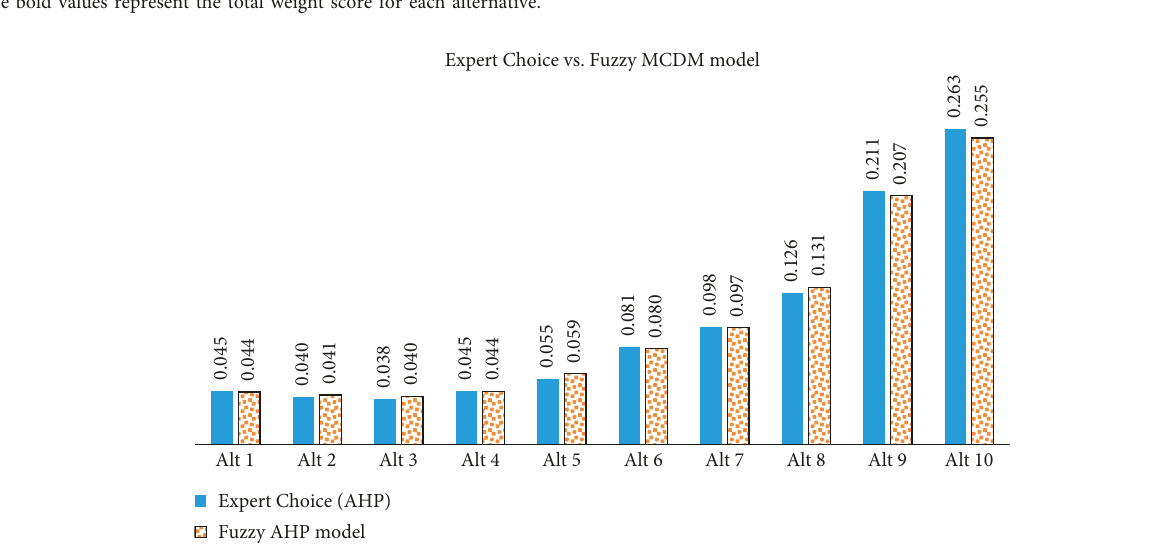
Figure 2: Expert Choice results vs FMCDM model results (case one). Table 5: Activity duration and cost.